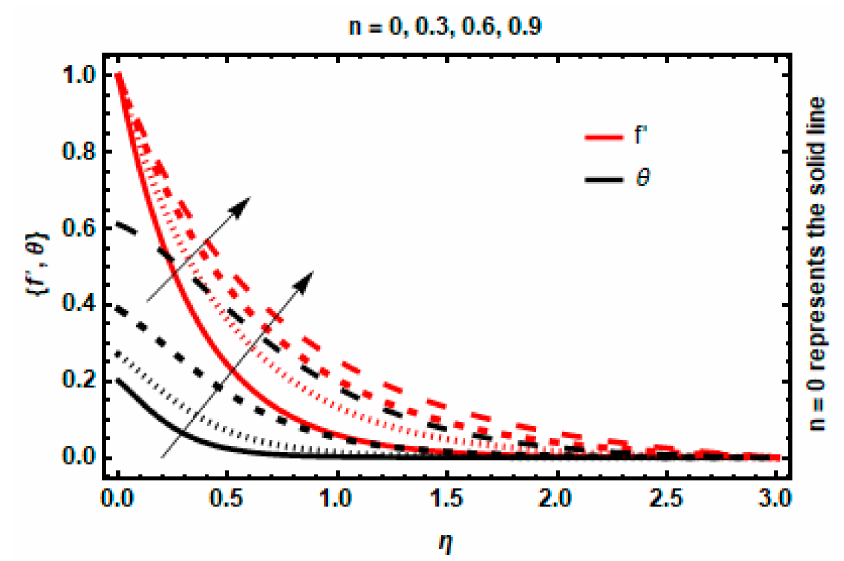
Figure 4. Impact of n on velocity and temperature.